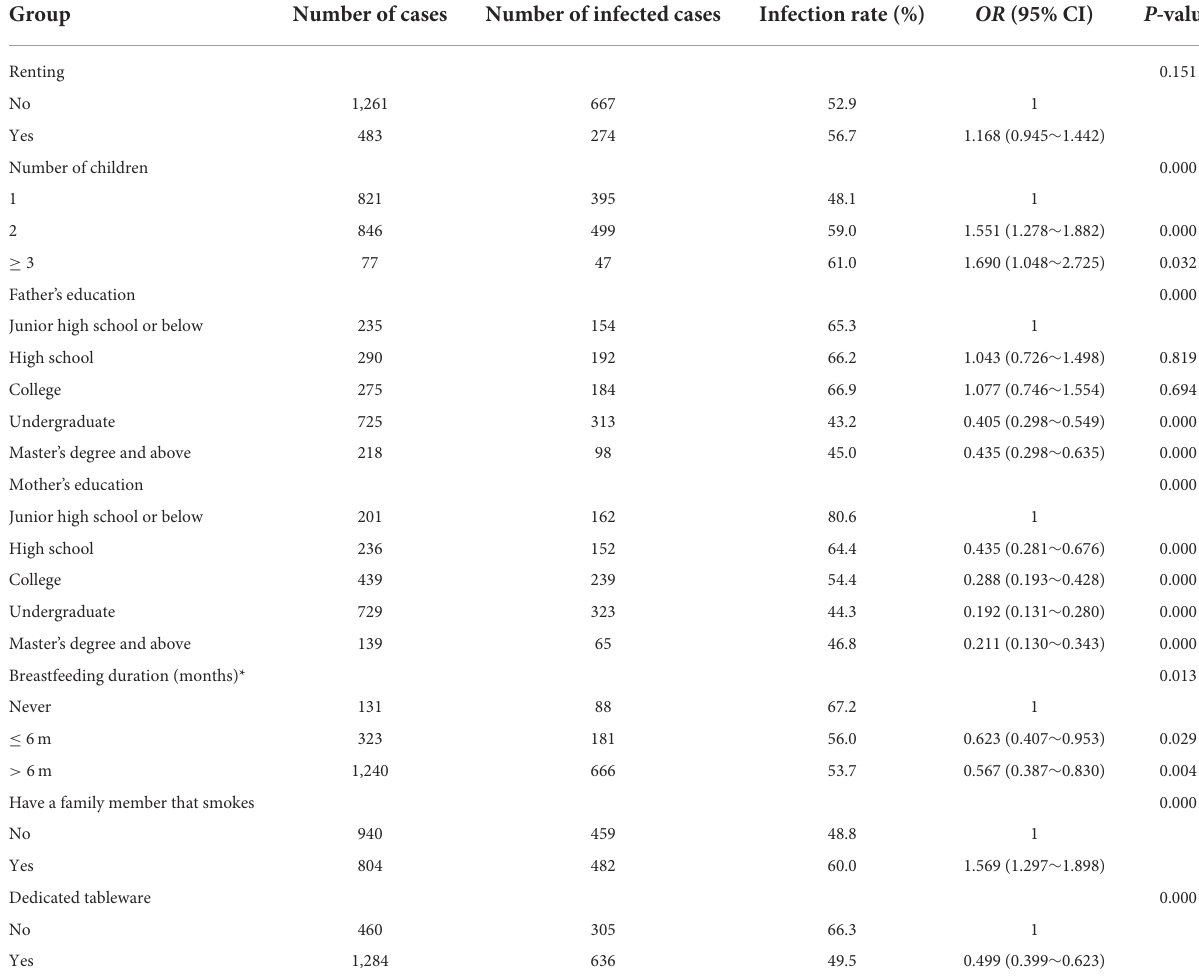
TABLE 3 Univariate logistic regression to determine the risk of EBV infection based on participant